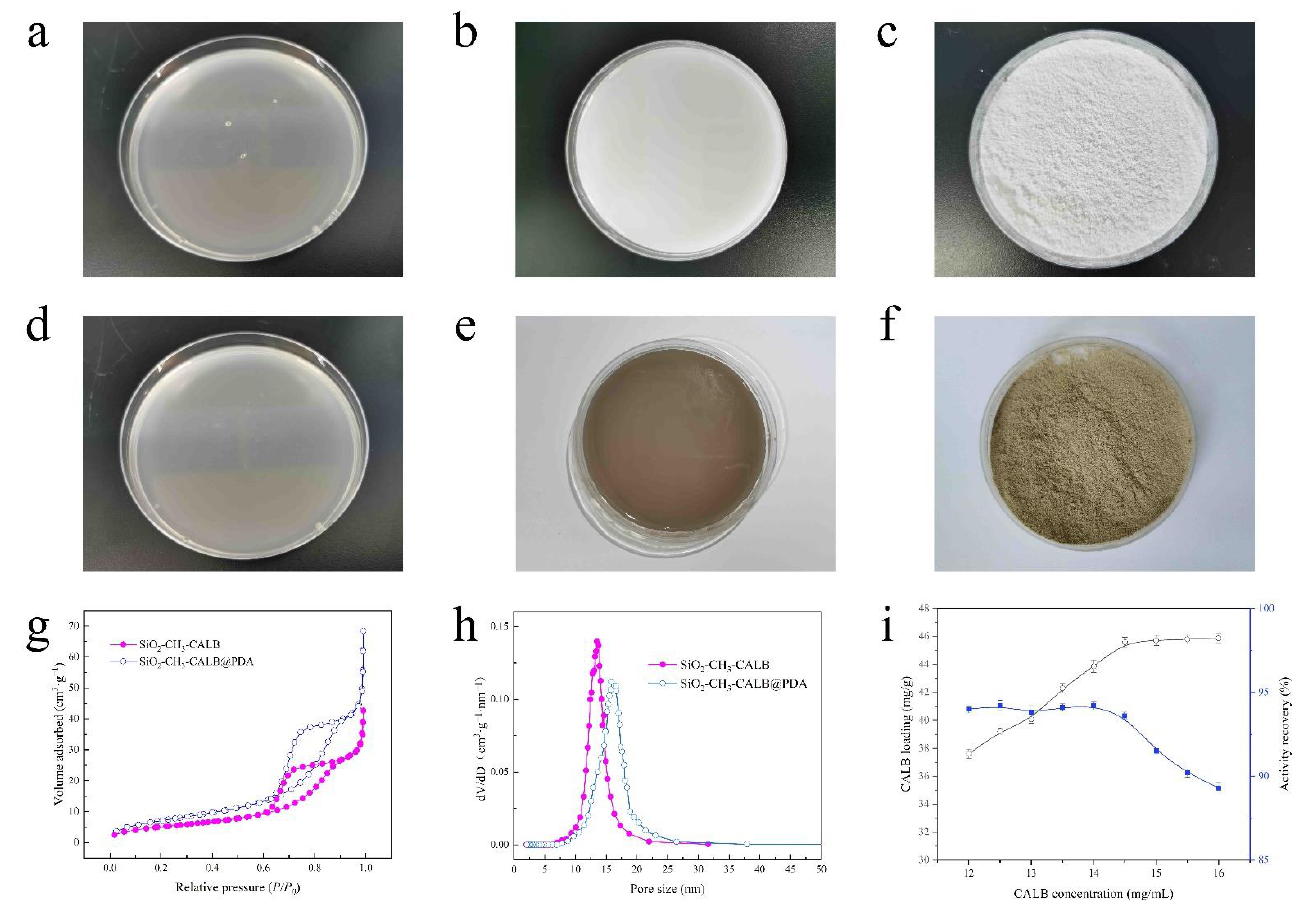
Figure 4. Sol−gel process of ( a – c ) SiO 2 –CH 3 –CALB, ( d – f ) SiO 2 –CH 3 –CALB@PDA, ( g , h ) pore structure and ( i ) enzyme load- ing.